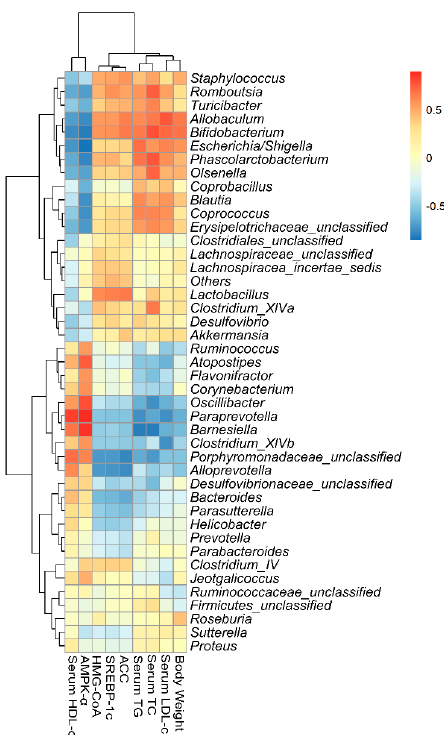
Figure 5. Statistical Spearman’s correlations between the caecal microbiota of significant differences and lipid metabolic parameters in SPL95, HFD, and NFD groups. The intensity of the color represents the degree of association between caecal microbiota of significant differences and MetS-associated parameters. Int. J. Mol. Sci. 2018 , 19 , x FOR PEER REVIEW